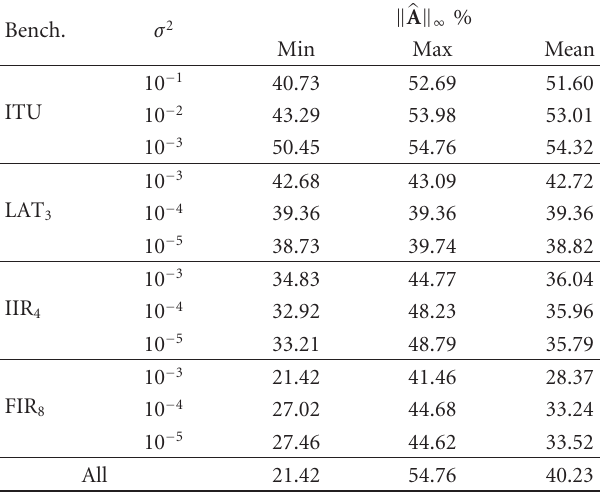
Table 5: MWL synthesis: homogeneous versus